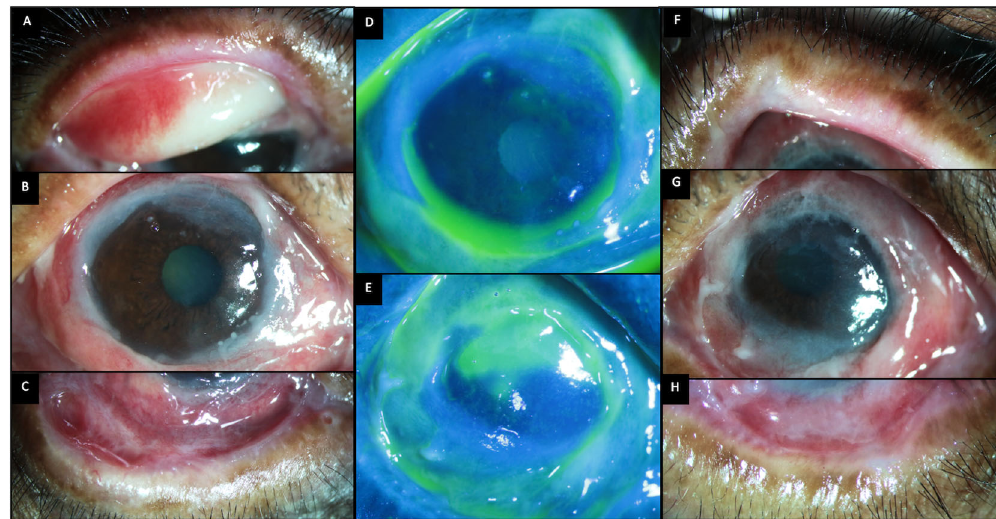
Figure 8. Ocular clinical features at presentation of case 4. (A-C) Slit lamp images of the right eye showing thickened distorted mucocutaneous junctions, tarsal scarring superiorly and inferior forniceal shortening with symblephara. (D, E) Fluorescein-stained images of the right and left eyes respectively showing diffuse punctate keratitisin therighteye andasuperiorepithelialdefect inthe lefteye.(F-H) Images oftheleft eye showingthickened distorted mucocutaneous junctions and obliteration of the inferior fornix. The bulbar conjunctiva also shows thickened fibrotic changes.